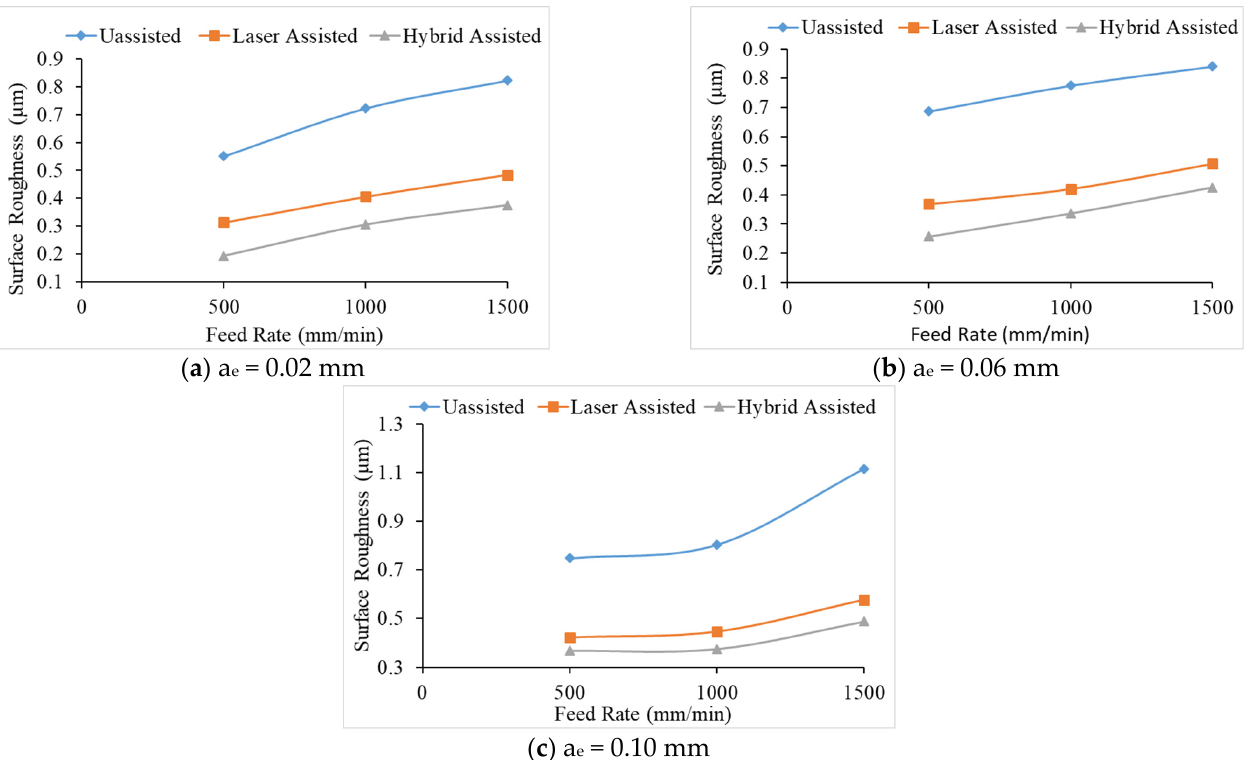
Figure 5. The relationship between radial depth of cutting and surface roughness under different feeds for unassisted, laser-assisted, and hybrid-assisted systems.